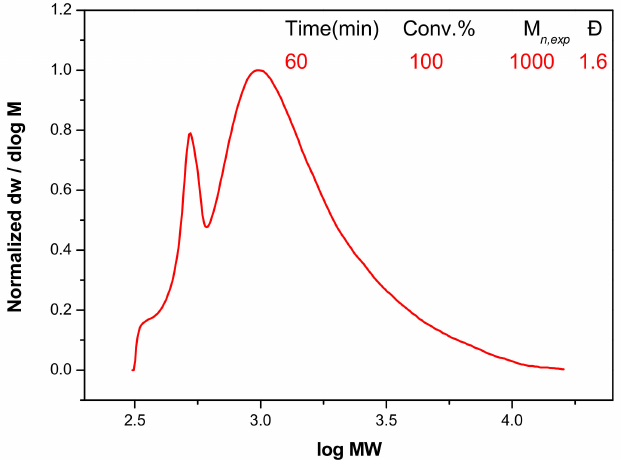
Figure 6. DMF SEC molecular weight distributions for PNIPAM via Cu(0)-mediated polymerization in H 2 O at 0.0 ◦ C. [chloro-initiator]:[CuCl]:[Me 6 TREN] =